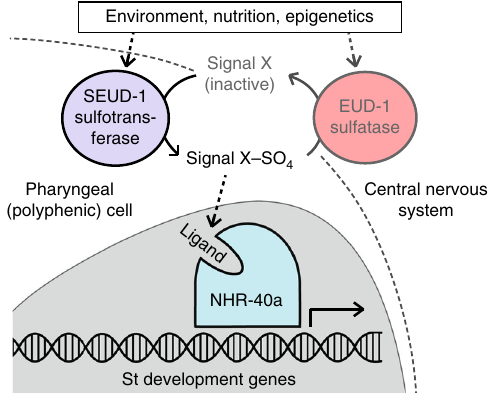
Fig. 5 A genetic model for polyphenism regulation and its potential evolutionary targets. A signalling mechanism originating in somatic neurons is integrated at the site of the polyphenism, where seud-1 and nhr-40 are expressed. Results suggest a model whereby the maintenance of a sulfated signal, possibly modi fi ed extracellularly by the signal peptide-including isoform of EUD-1 3 , promotes St-morph gene transcription (or, alternatively, Eu-morph gene repression) through NHR-40, particularly its complete (DNA-binding and ligand-binding) isoform (NHR-40a). Consistent with previous studies of morph-inducing cues, function, and expression of seud-1 suggests that this switch mechanism may be responsive to cues throughout postembryonic development, before making its irreversible decision at the J4-adult moult. The threshold for the morph ratio is thus set by the relative dosage of two enzymes of opposing function, such that changes to